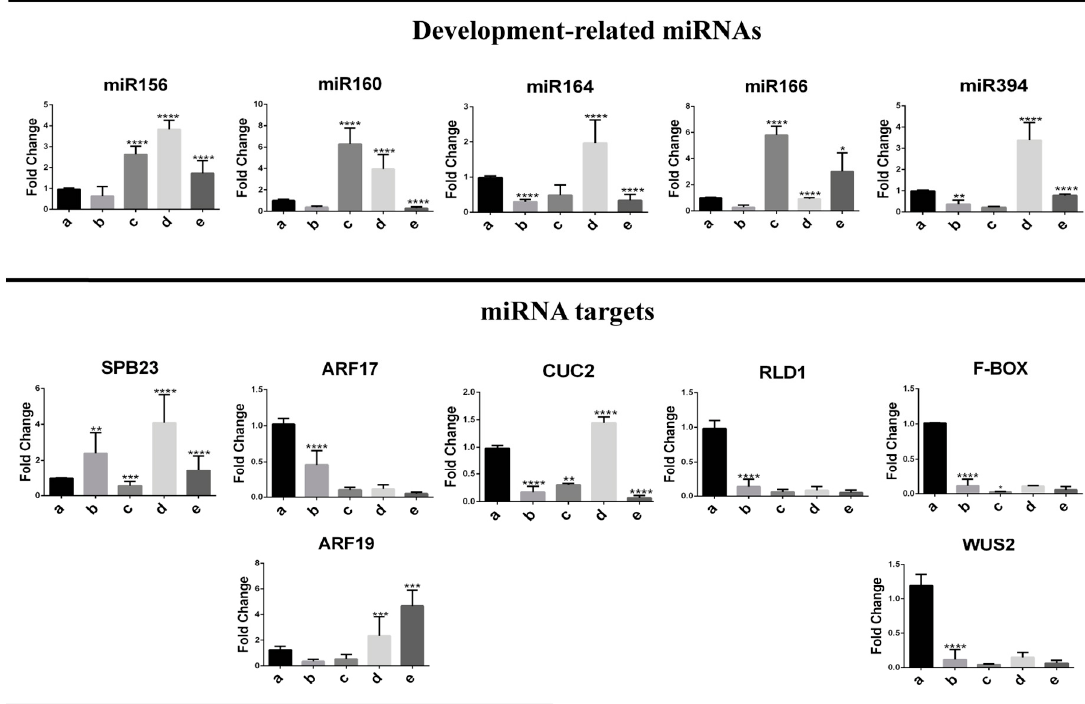
Figure 5. Abundance patterns of development-related miRNAs and their targets during maize VS-535 plant regeneration. miRNA and mRNA levels were analyzed by qRT-PCR during staggered hormone depletion and photoperiod for Tuxpeño VS-535 plant regeneration. (a) EC, (b) 1st stage of development, (c) 2nd stage of development, (d) 3rd stage of development, (e) Plantlet. Each miRNA target is shown below the corresponding miRNA, except for WUS2, which is not a direct target of miR394, but is instead regulated by an F-Box protein target of miR394. Fold change represents abundance relative to the EC and normalized by U6 snRNA internal control for miRNAs and 18S rRNA for targets. Significant values are indicated as follows: (*) p < 0.05, (**) p < 0.01, (***) p < 0.001, (****) p < 0.0001.